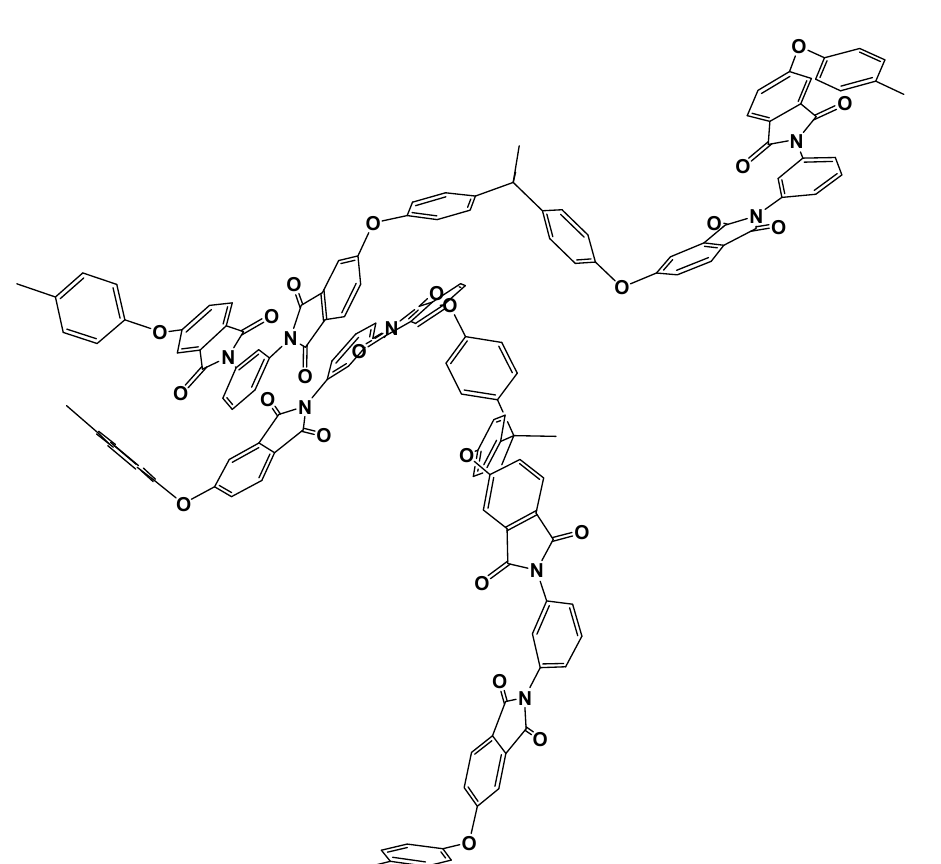
Figure 5. Potential relative position of PI fragments responsible for the presence of π – π interaction between Im–Ph–Im’ fragments and an increase of inter-chain distance between Ph–O–Ph’ fragments.